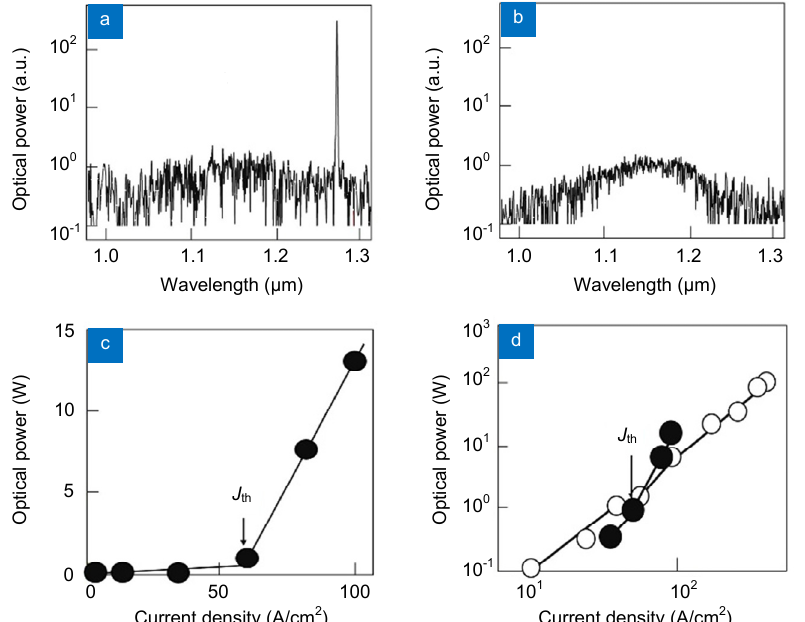
Fig. 5 | Light emission spectra and output optical power of Si lasers. ( a ), ( b ) Spectral profiles above and below the threshold, respectively, of a 550 μ m-length device with a ridge waveguide. The threshold current density was 1.1 A/cm 2 under CW operation at room temperature (25 ℃ ). ( c ), ( d ) Relation between the injected current density and the output optical powers of 15 mm-long and 30 mm-long devices, respec- tively. J th is the threshold current density. Closed circles in (d) are a copy of those in